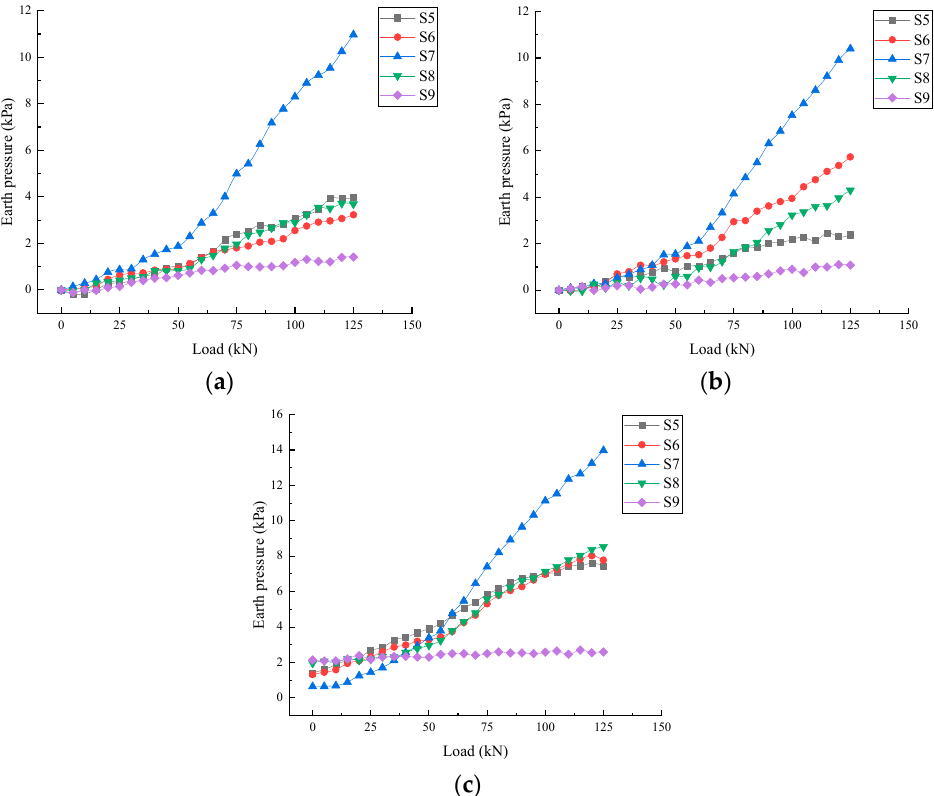
Figure 11. Variation of horizontal earth pressure at measured points along the bottom of the slope with the slope top load ( a ) Test G1 plain soil slope. ( b ) Test G2 bamboo-rooted slope. ( c ) Test G3 rainfall bamboo-rooted slope.